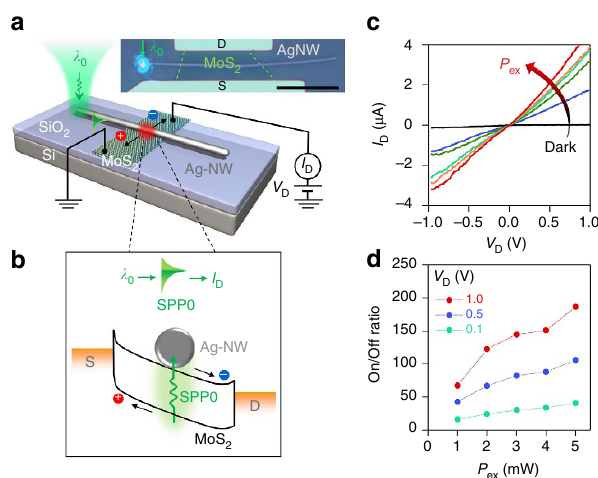
Figure 4 | Electrical detection of plasmons. ( a ) An Ag-NW overlapped on the MoS 2 FET. Incident l 0 at the end of NW is converted to SPP0. The propagating SPP0 along the NW is absorbed in MoS 2 and converted to photocurrent ( I D ) at the NW/MoS 2 overlapping region. Scale bar: 10 m m. ( b ) Schematic description of photocurrent generation via plasmon-to- charge conversion at the NW/MoS 2 overlapping region. ( c ) I D -V D curves of MoS 2 FET for various P ex ranging from 1 to 5mW. Black curve: laser-off state (Dark). ( d ) On/Off ratio as a function of P ex for the selected V D from ( c ).